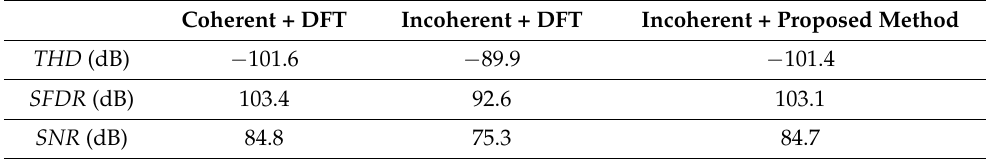
Table 2. The THD , SFDR , and SNR values obtained under coherent and incoherent sampling, β = 0.02.